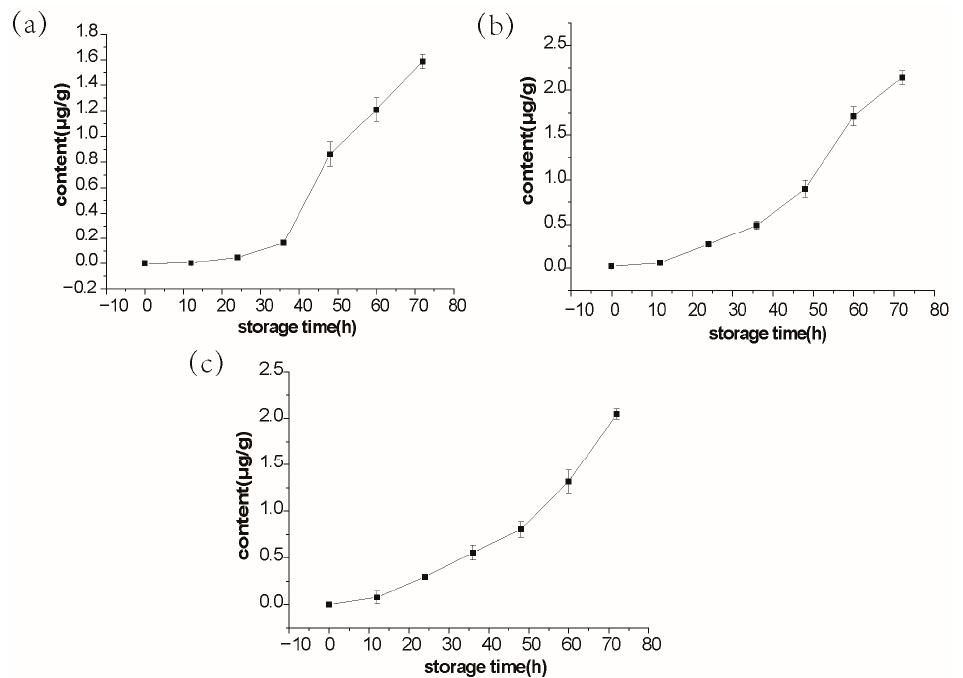
Figure 5. Content changes of three compounds of salmon at 25 °C as measured by GC-MS: ( a ) 3-methyl-1-butanol; ( b ) 1,3-di-tert-butylbenzene; ( c ) acetic acid.